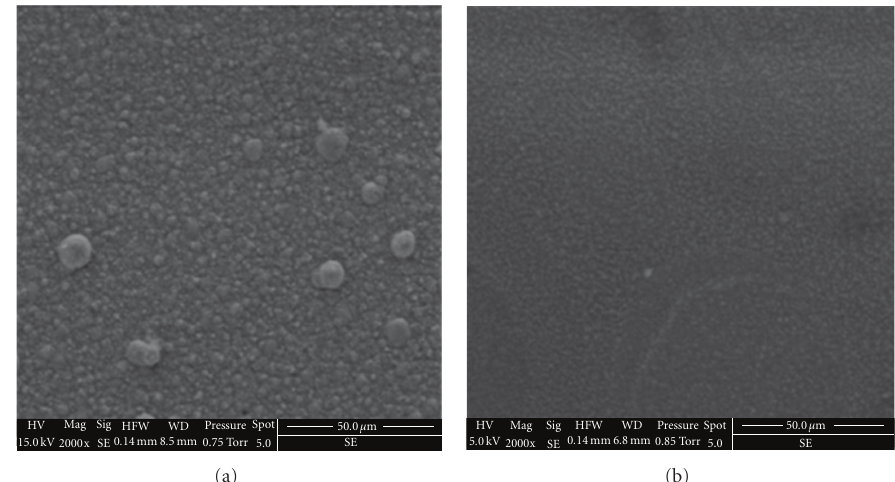
Figure 9: SEM Zn-Ni electrodeposited on steel at 4 mA/cm 2 from a bath containing 0.02 M ZnSO 4 , 0.02 M NiSO 4 , and 0.5M Na 2 SO 4 . (a) Without boric acid, (b) | H 3 BO 3 | = 0.8M.